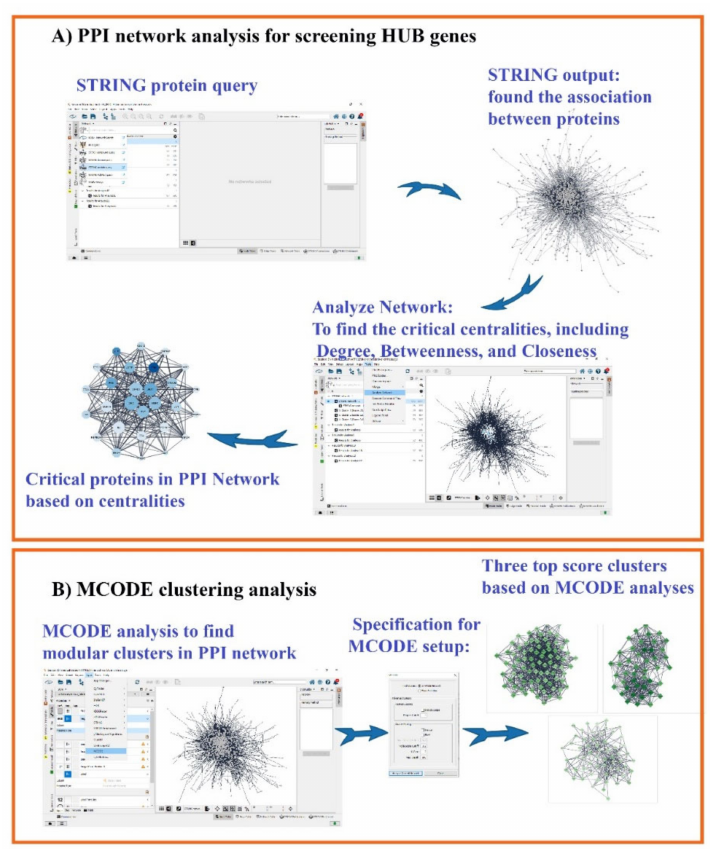
Figure 2. The methodology for screening hub genes through analyzing centralities ( A ) and modular clusters via MCODE analysis ( B ). PPI—protein–protein